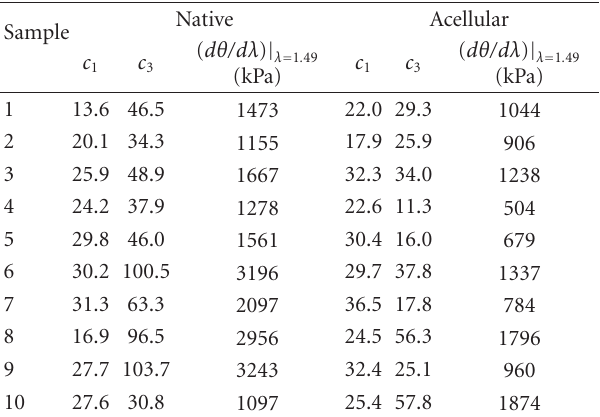
Table 6: Extended data for Protocol